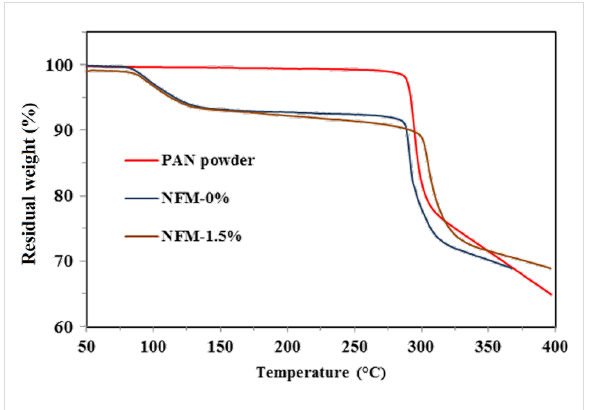
Figure 7: TGA thermograms for pure PAN powder, NFM-0% and